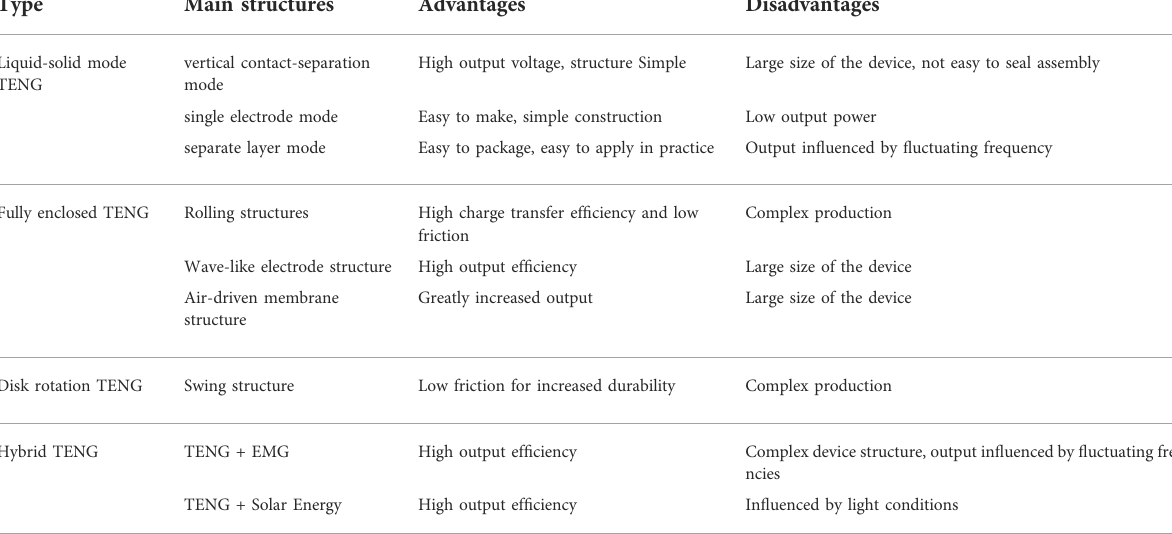
TABLE 1 Comparison of the characteristics of TENG in different